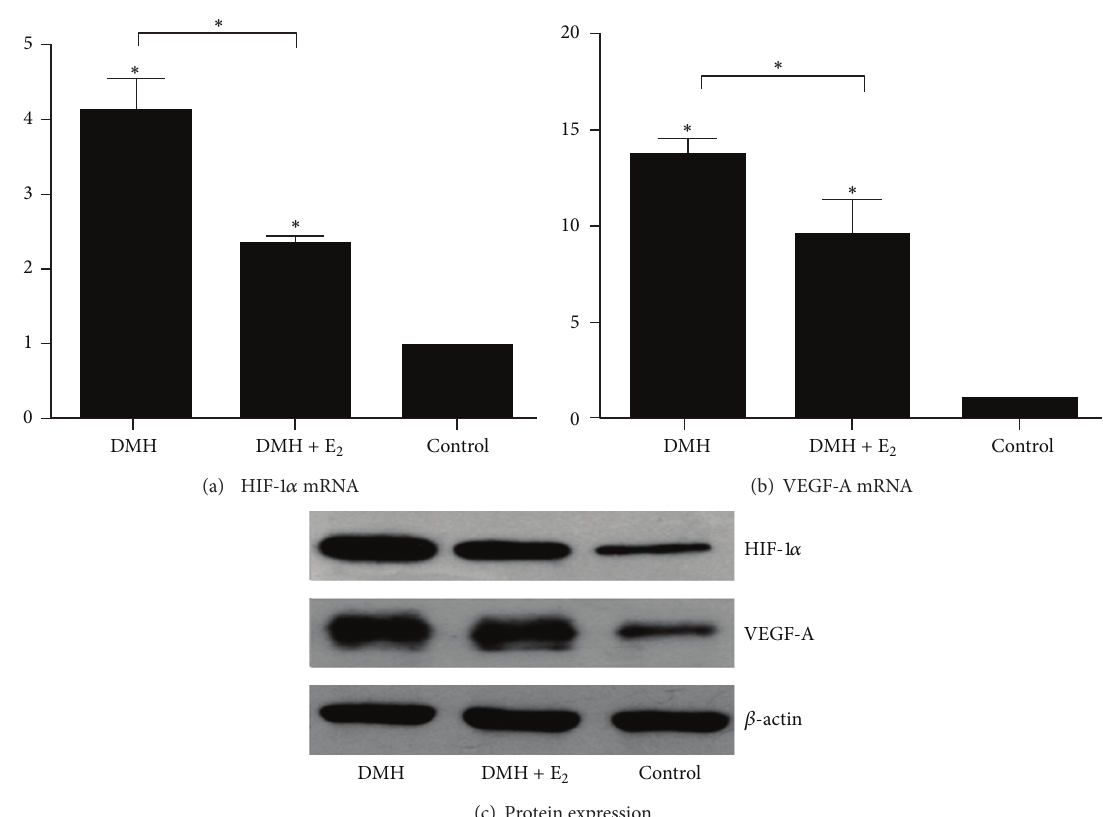
Figure4:ExpressionsofHIF-1 𝛼 andVEGFatmRNAandproteinlevel.(a)ComparisonofHIF-1 𝛼 mRNAlevelindifferentgroups( ∗ 𝑃 < 0.05 ). (b) Comparison of VEGF-A mRNA level in different groups ( ∗ 𝑃 < 0.05 ). (c) Representative immunoblot analysis of HIF-1 𝛼 and VEGF-A protein expressions in each